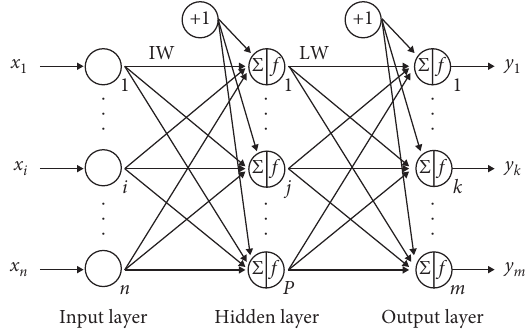
Figure 1: BP neural